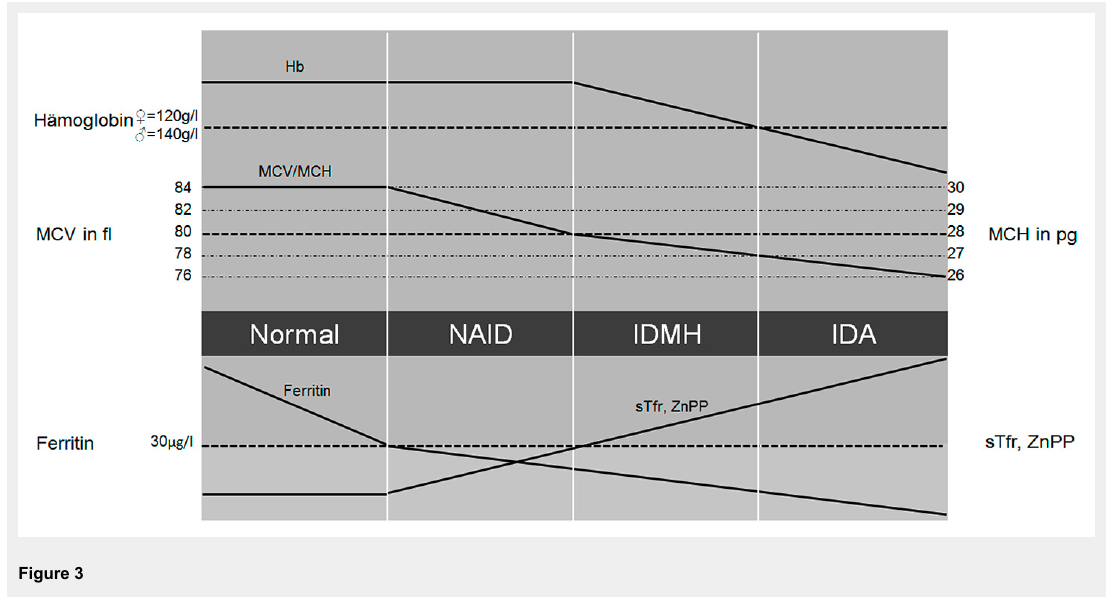
Figure 3 Stages of iron deficiency. Hb = haemoglobin; IDA = iron deficiency anaemia; IDMH = iron deficiency with microcytosis and/or hypochromia; MCH = mean cellular haemoglobin; MCV = mean cellular volume; NAID = nonanaemic iron deficiency; sTfr = soluble transferrin receptor; ZnPP = zinc protoporphyrin